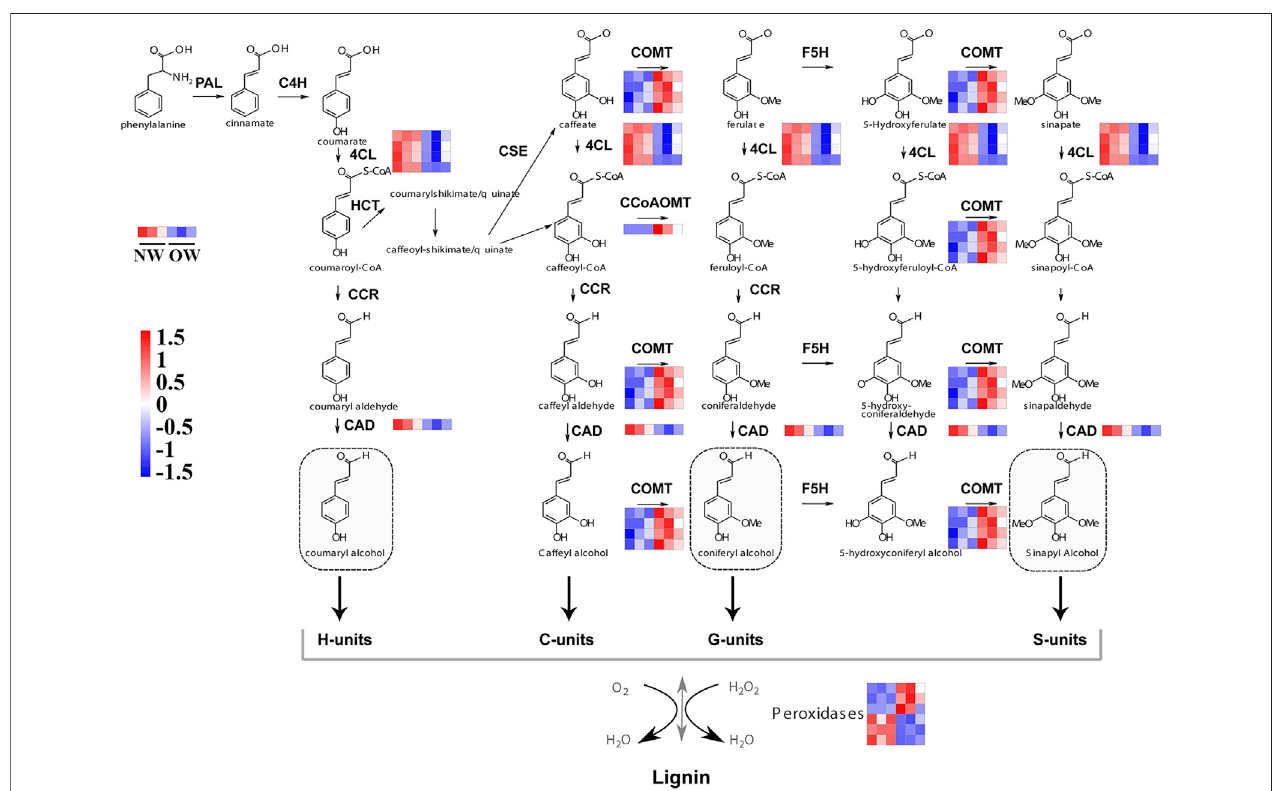
FIGURE 4 | Expression of genes in phenylpropanoid biosynthesis pathway in OW vs. NW. Red represents up-regulation and blue represents down-regulation. PAL, Phenylalanine ammonia-lyase; C4H, Cinnamate 4-hydroxylase; 4CL, 4-coumarate-CoA ligase; F5H, Ferulate 5-hydroxylase; CCoAOMT, Caffeoyl-CoA O-methyltransferase; CCR, Cinnamoyl-CoA reductase; CAD, Cinnamyl alcohol dehydrogenase; COMT, Caffeate O-methyltransferase; HCT, hydroxycinnamoyltransferase; POD, peroxidase.